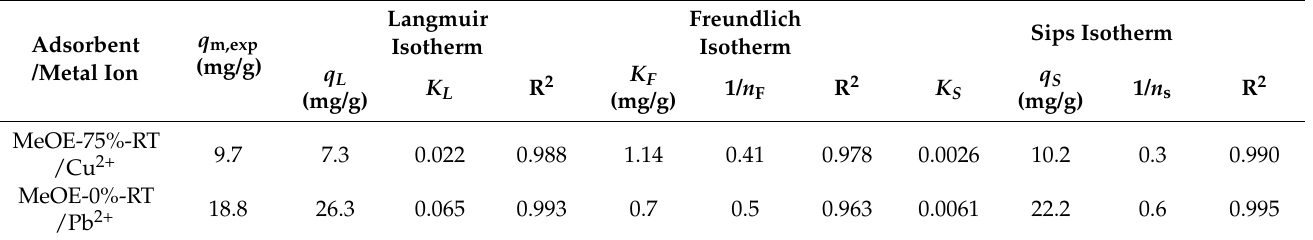
Table 2. Langmuir, Freundlich and Sips isotherm parameters for Cu(II) ions adsorption on sample MeOE-75%-RT and Pb(II) on